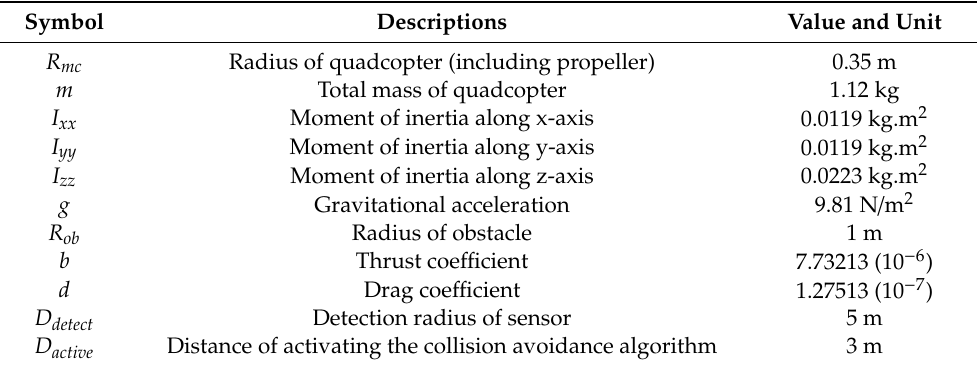
Table 1. System’s parameters of quadcopter for